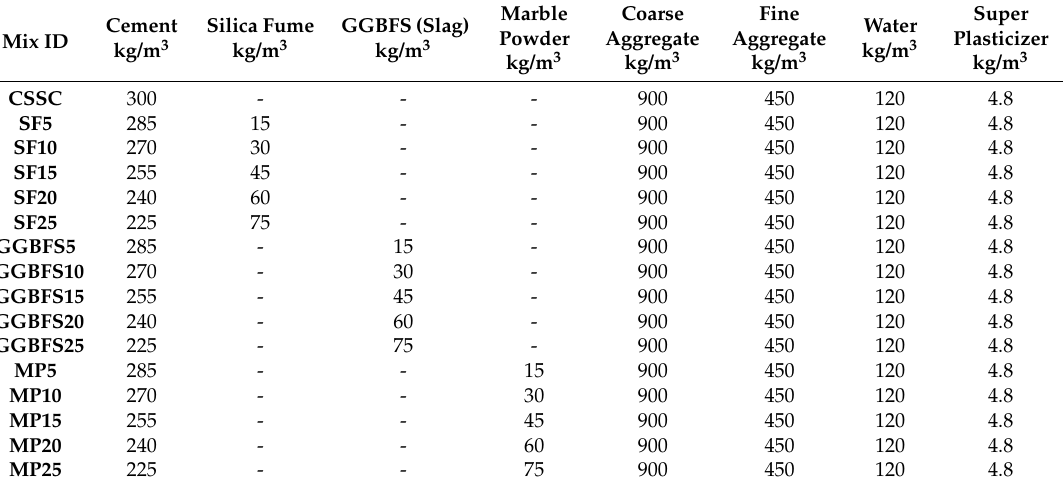
Table 2. Quantities for mixing and development of